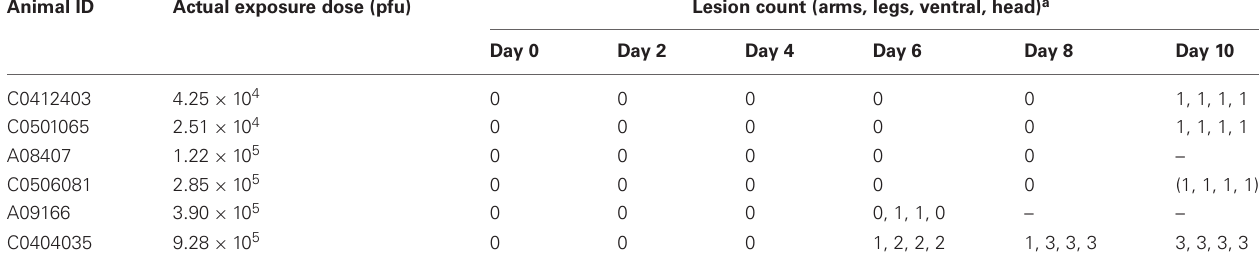
Table 2 | Lesion count summary.